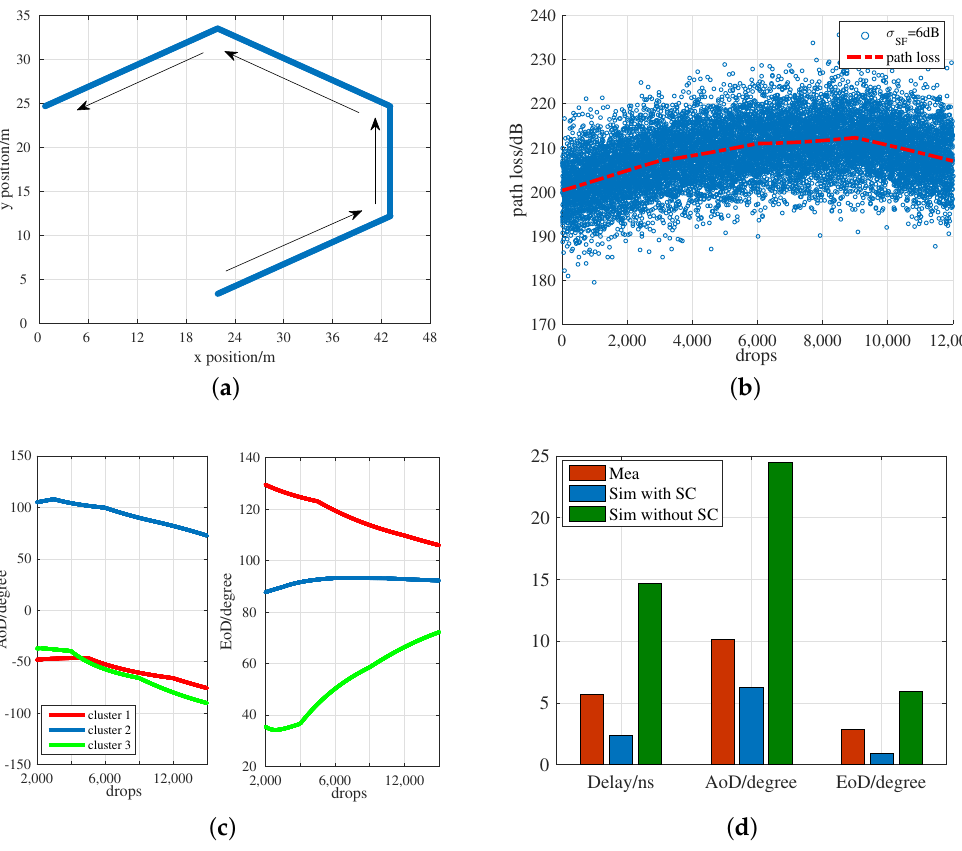
Figure 7. Profiles of the IMT-2020 channel simulations in UMa, 3.5 GHz, and STD comparisons among measurements and simulations with and without spatial-consistency feature. Note: AoD, azimuth angle of departure; EoD, elevation angle of departure; STD, standard deviation. ( a ) MS moving trajectory. ( b ) Simulation path loss model. ( c ) AoD and EoD of first three clusters (three largest powers). ( d ) Delay STD, AoD, and